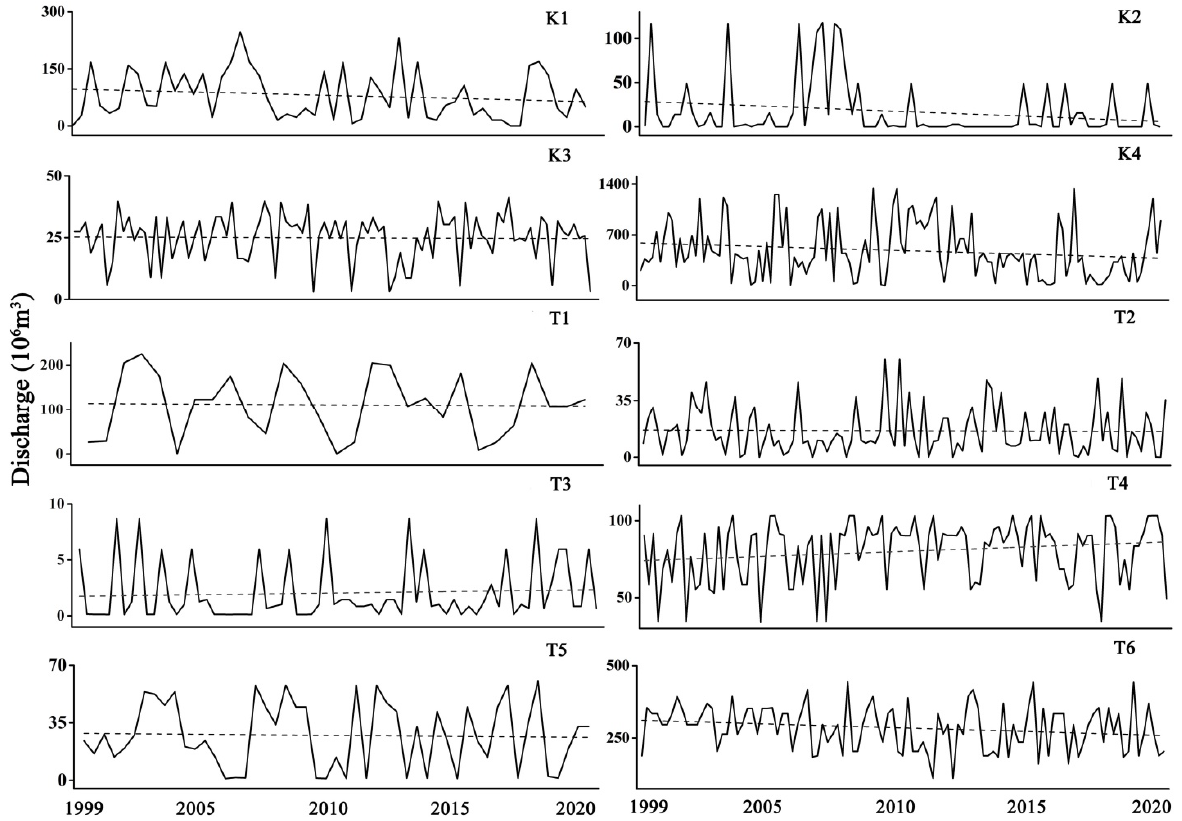
Figure 7. The changes of monthly discharge in different river sections during 1999–2020.